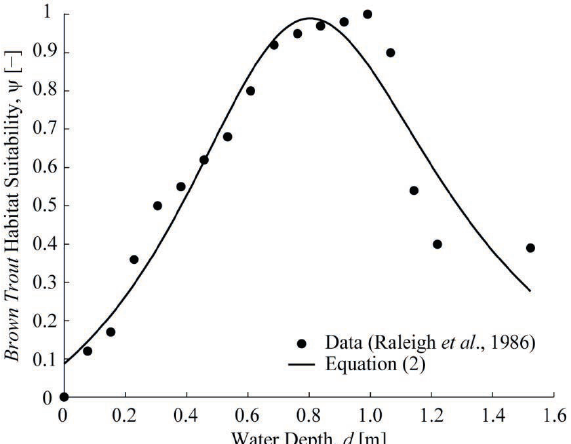
Fig. 2 Habitat suitability curve for brown trout: comparison between data (Raleigh et al . 1986) and the analytical model expressed by equation